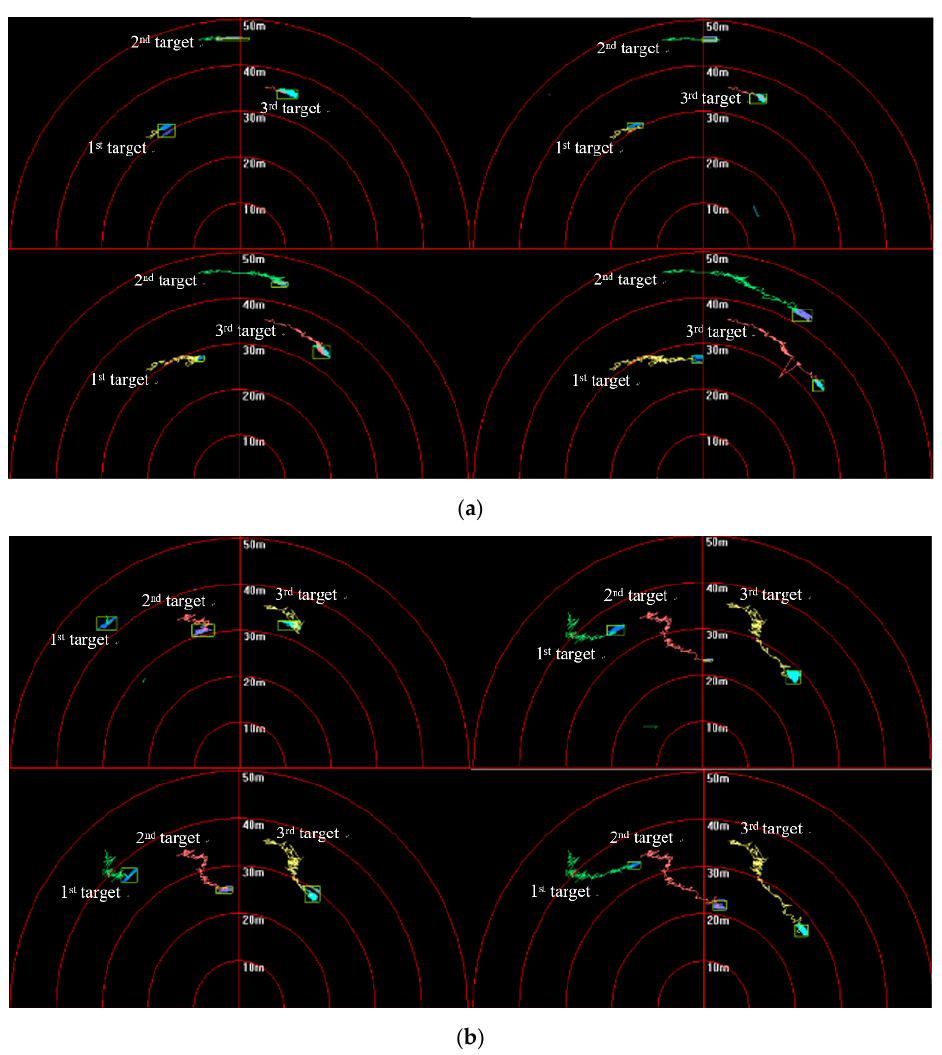
Figure 22. Target-tracking results in: ( a ) first and ( b ) second sequence of forward-looking-sonar (FLS) images.